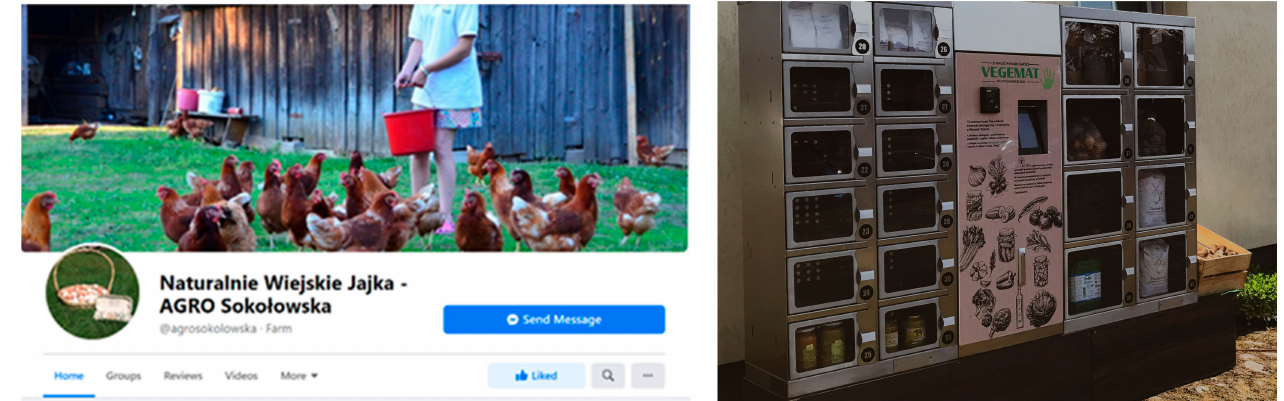
Figure 2. Examples of social initiatives within the food supply chain during the COVID-19 pandemic in Poland (KARMNIK on the left and Sp ó łdzielnia Ostoja on the right). The source of picture on the left is: https://www.facebook.com/agrosokolowska (accessed 12 December 2020) and the source for the picture on the right: https://ostojanatury.pl/bio-hub/ (accessed 29 December